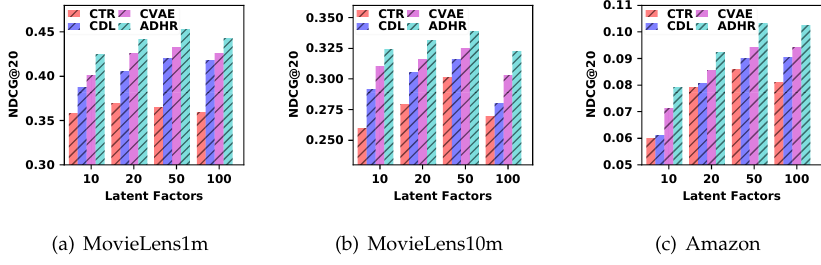
Figure 4. Warm-start recommendation performance w.r.t. latent dimensionality.